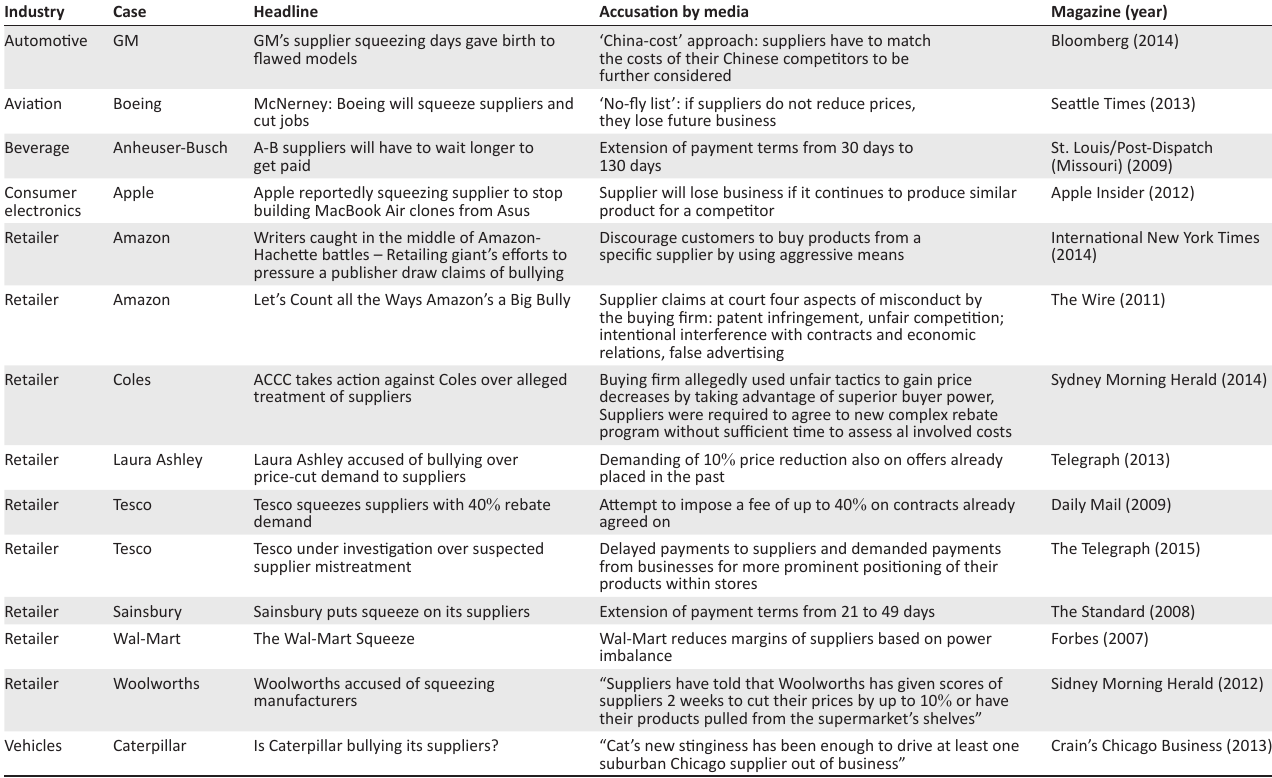
TABLE 1: Supplier squeezing in the media, selected